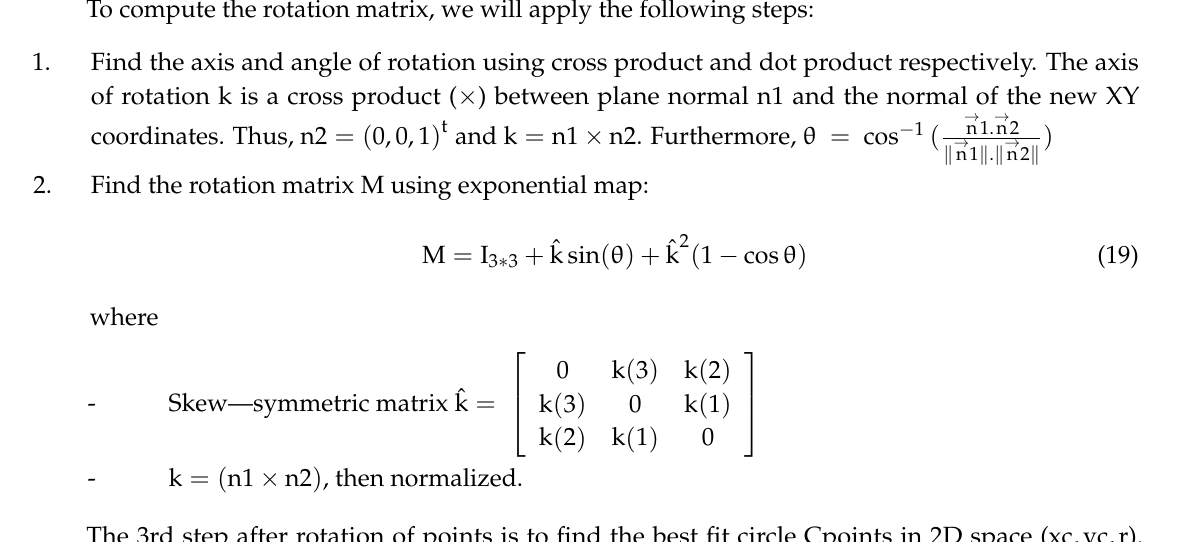
Figure 6. Rotating from normal vector 𝑛1 to normal 𝑛2 .